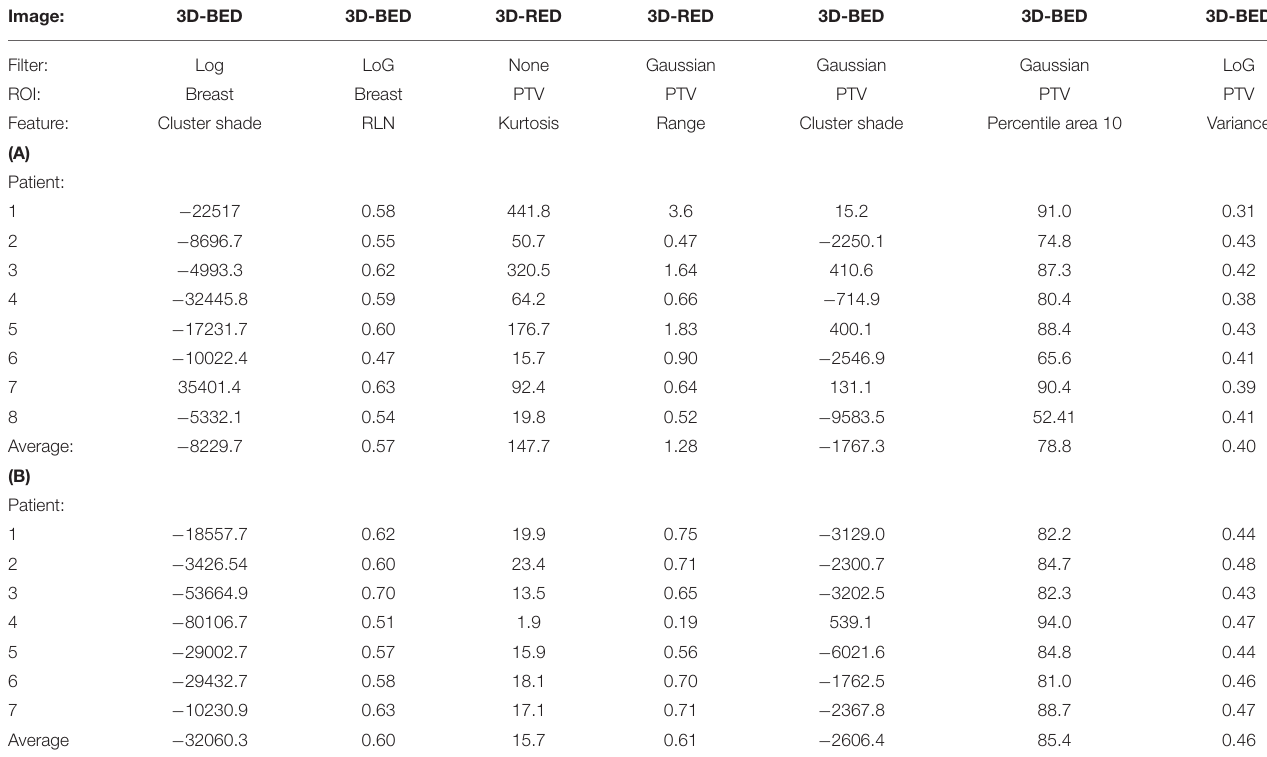
TABLE 4 | Values of radiomic variables of the patients with low (A) and high (B) risk of RIF. Image: 3D-RED